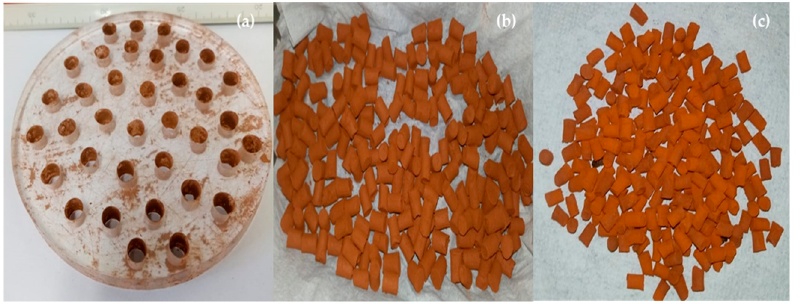
Figure 6. Production of activated red mud Material pellets before and after calcination. Acrylic mold ( a ); red mud pellets before calcination ( b ); and red mud pellets after calcination ( c ).